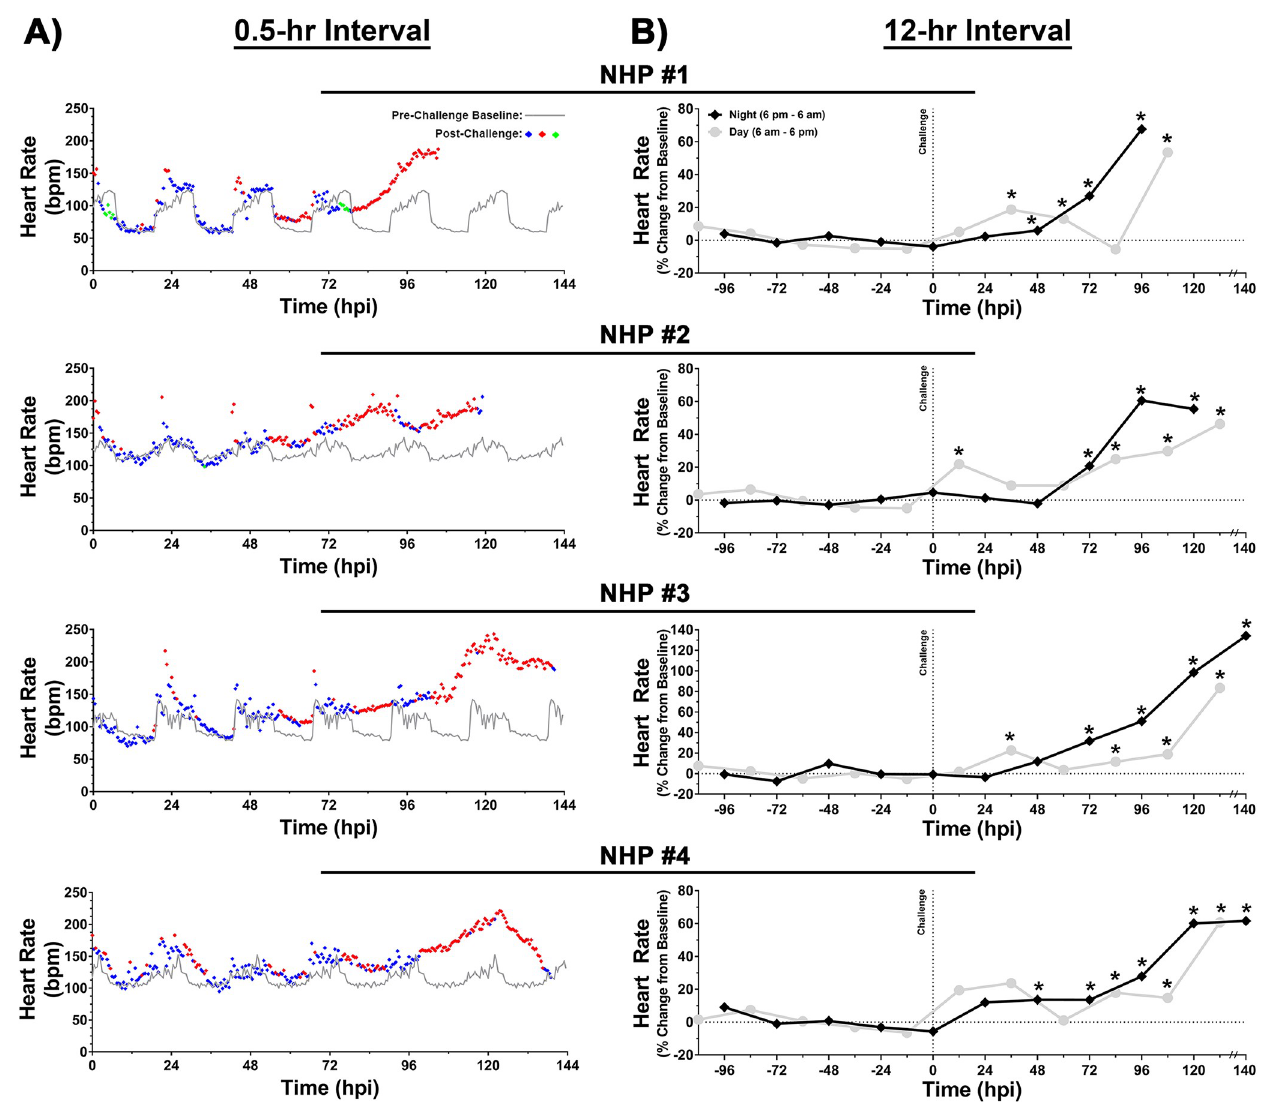
Fig 7. Heart rate of NHPs pre- and post-EEEV challenge. Data analysis is shown in 0.5- (A) and 12-hr (B) daytime/nighttime intervals. All NHPs were continuously monitored pre- and post-challenge. Pre-challenge baseline heart rate was measured for five day/night cycles and a 0.5-hr interval baseline average was calculated by averaging raw data of five time-matched day or night time intervals. Forty-eight 0.5-hr interval averages were used to construct a baseline heart rate for a day/night cycle and is shown as a grey line (A).Post-challenge values within � 3 standard deviations (SD) are indicated with ( ), > 3 SD above baseline are indicated with ( ), and > 3 SD below baseline are indicated with ( ). Percent change from baseline in 12-hr interval is shown in grey (daytime) and in black (nighttime) (B). All raw data from either 12-hr daytime or nighttime intervals were averaged and normalized. The last data point for NHP #3 and 4 is an average of 8 hrs (B). p -values � 0.035 are indicated with � . bpm = beats per